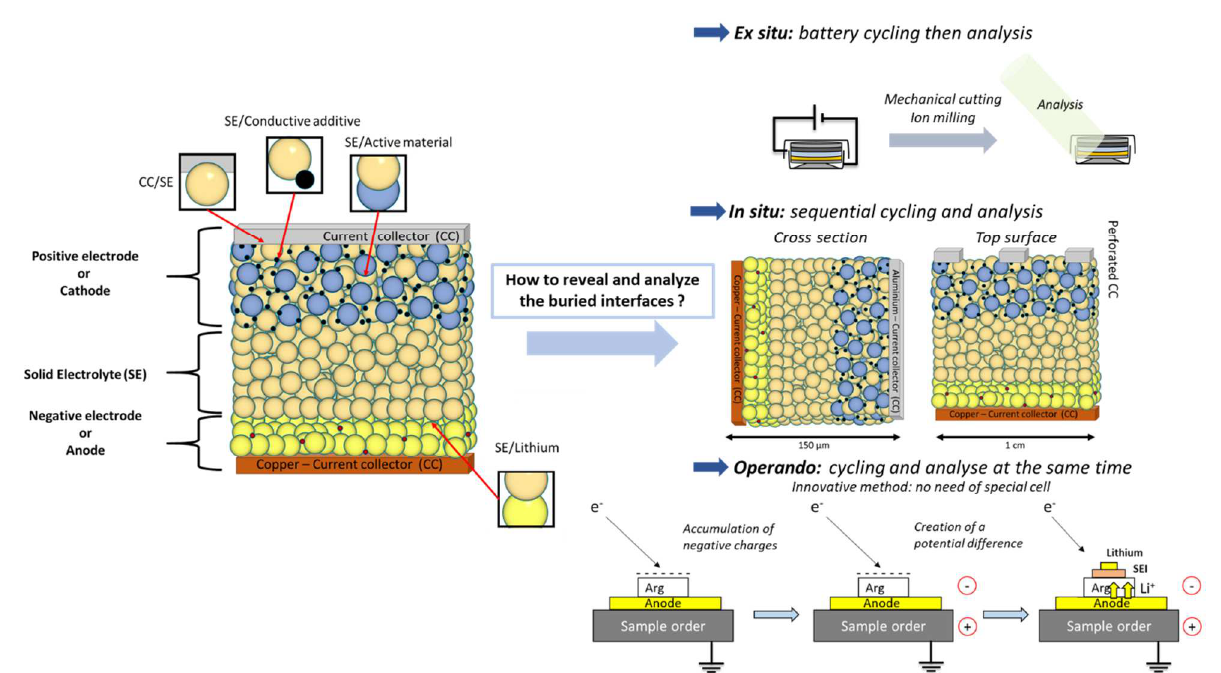
Fig. 1. Schematic illustration of buried interfaces in SSBs and the ex situ , in situ and operando approaches to analyse